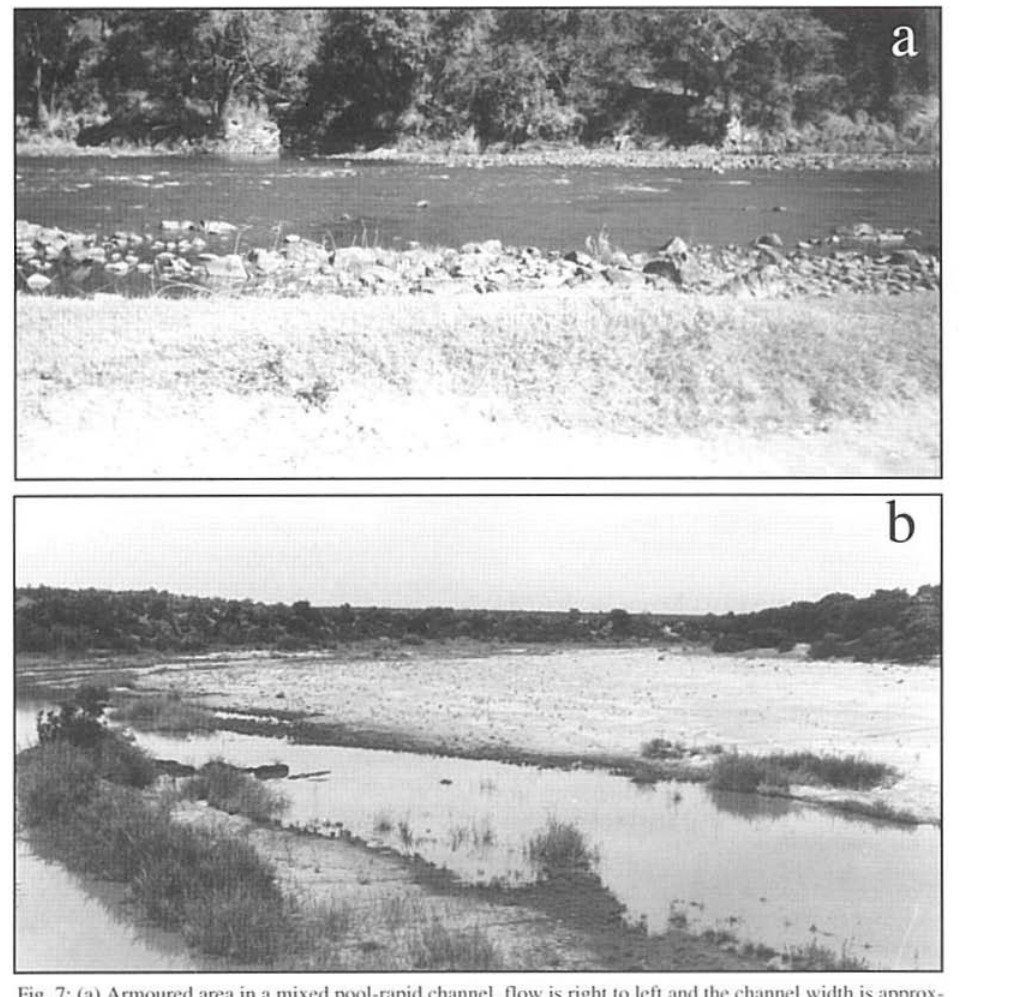
Fig. 7: (a) ,\rmourcu :orca in a mixed pool-r..pitl channel. nOl\ i~ right 10 lefl :UlU Ihe ch:umd "idlh is approx imately 40m. (b) ~inglc thread channel hightigluing :111 cX!.::Il,j,·c \;IJ\U ,heet. f\. ... -d·cu\crcd mid-channel b;,r ~nd ct)hc~i\'c Iuw ICTr.I!.-C deposits <II the m:trt;in\ of the m:,cro.-challncl. til\' ;Icli\'c ('halilid is